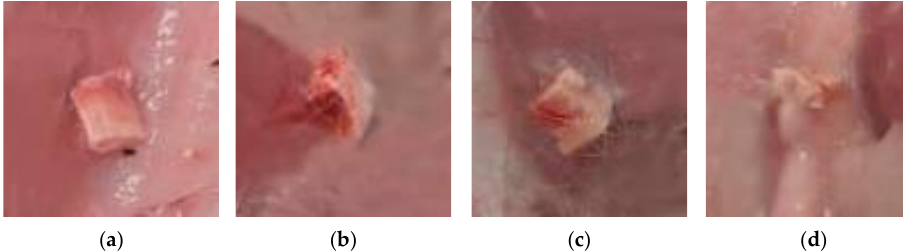
Figure 14. The pH metering of the aqueous solutions of ceramic samples fired at 1000 °C.